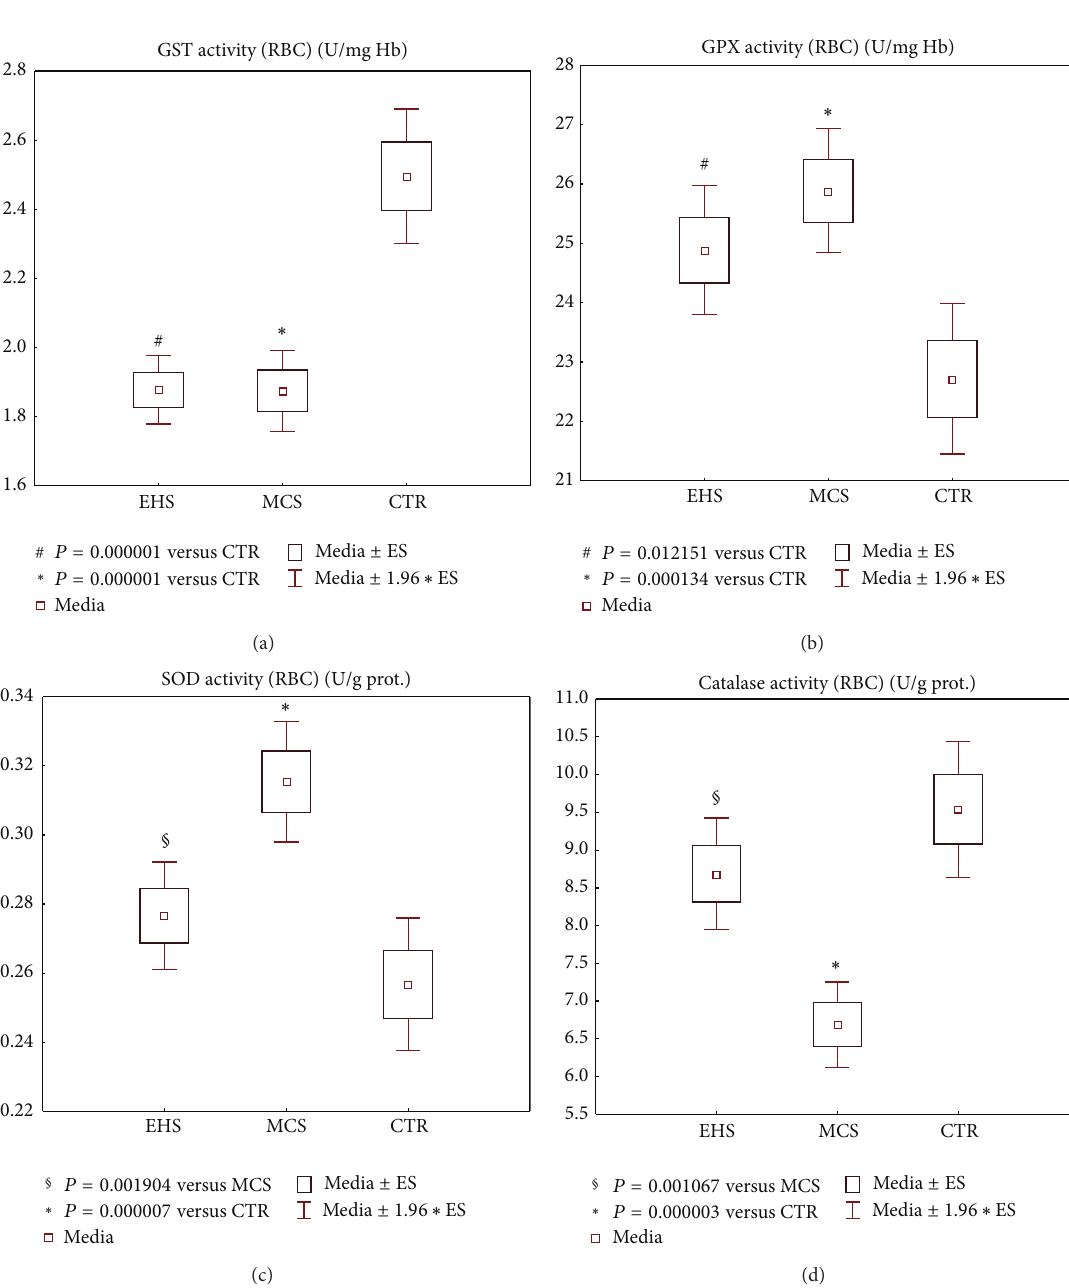
patient subgroups versus controls. Figure 6(c) reports